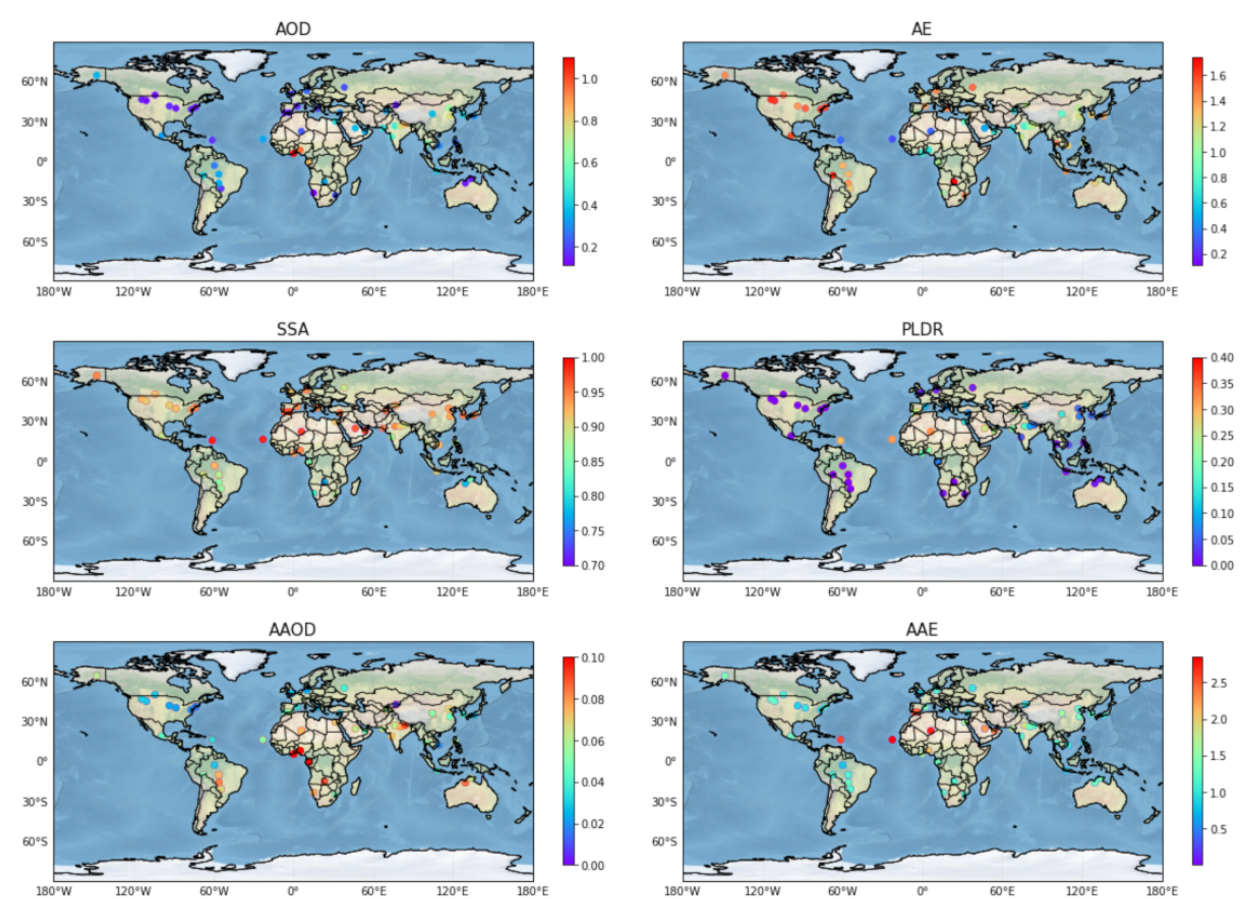
Figure 2. Scatter plots of AOD, AE, SSA, PLDR, AAOD, AAE distribution in the global range. The color dot in each station implies the mean values in the color